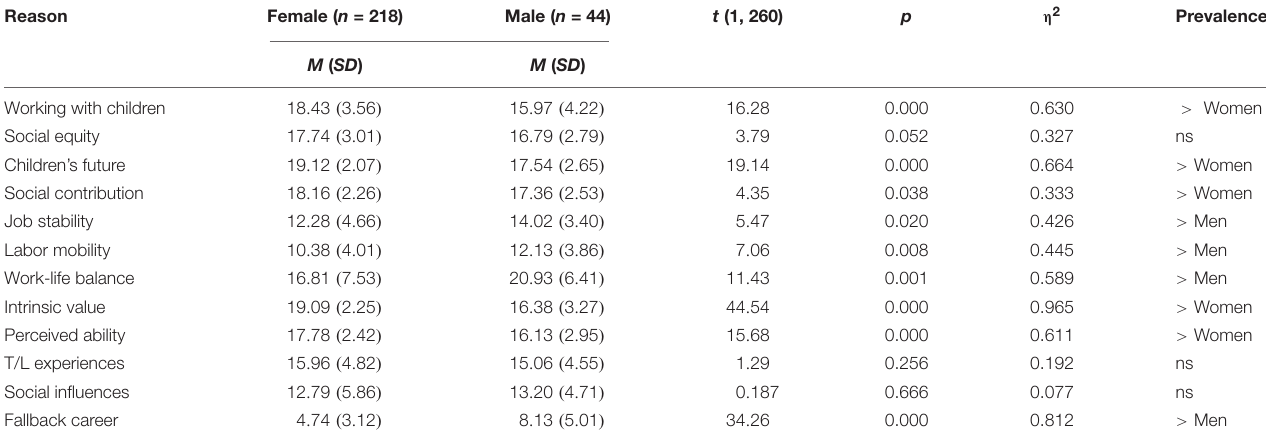
TABLE 3 | Means, standard deviations, Student’s t -test, and effect size ( η 2 ) of the reasons according to gender. Reason